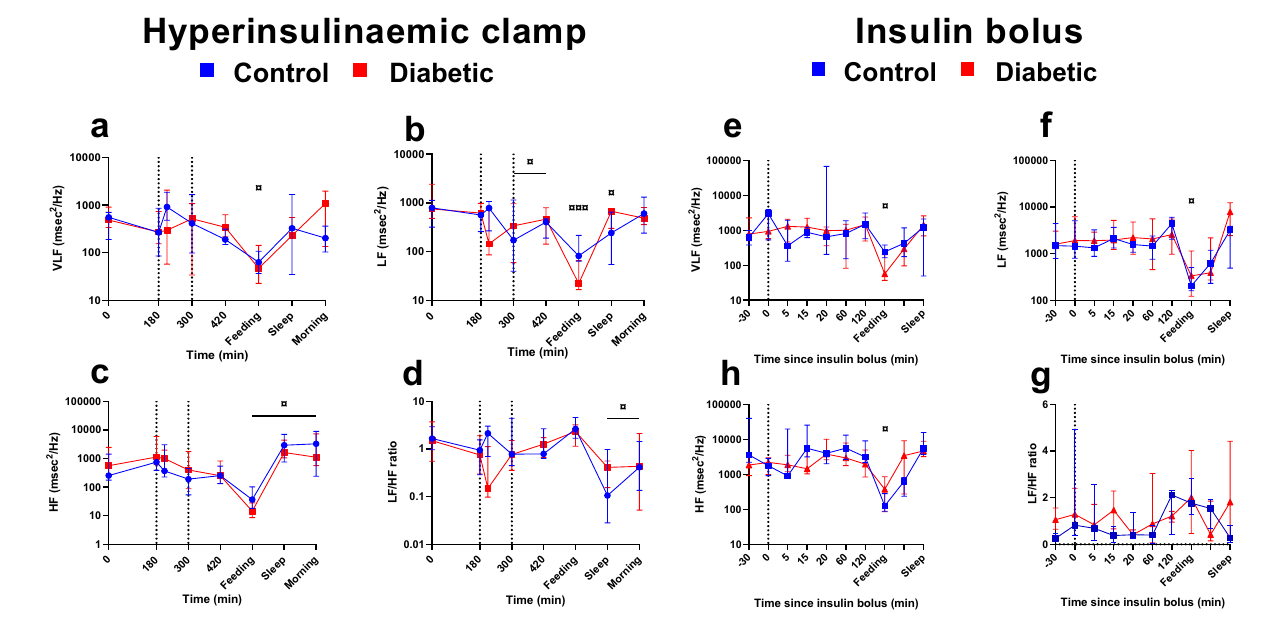
Figure 4. Frequency domain heart rate variability. Very low frequency band power (VLF) in msec 2 /Hz ( a + e ), low frequency band power (LF) in msec 2 /Hz ( b + f ), high frequency band power (HF) in msec 2 /Hz ( c + g ) and ratio between LF and HF power ( d + h ) during hyperinsulinaemic clamp and insulin bolus study. Clamp: blue lines: control pigs, red lines: diabetic pigs. Bolus: green lines: control pigs, orange lines: diabetic pigs. Y-axis is logarithmic. Data as medians ± interquartile range. Significant difference between groups as black stars (*). Significant difference to baseline within group is illustrated with accordingly colored stars (*), and, when both groups are considered together, as black currency sign ( ¤) . * P < .05, ** P < .001, *** P < .0001, by linear mixed modelling. Vertical lines: start and end of hypoglycaemia in the clamp or insulin bolus time. Software used to generate graphs: GraphPad Prism 8 (GraphPad Software Inc., San Diego,